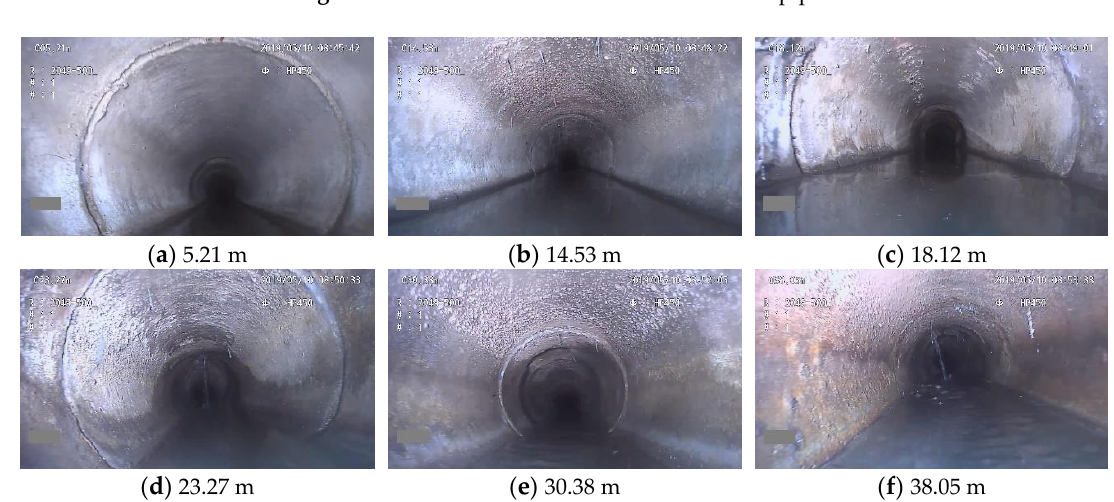
Figure 8. Water level at location ( a ) 5.21 m, ( b ) 14.53 m, ( c ) 18.12 m, ( d ) 23.27 m, ( e ) 30.38 m, ( f ) 38.05 m in CCTV.